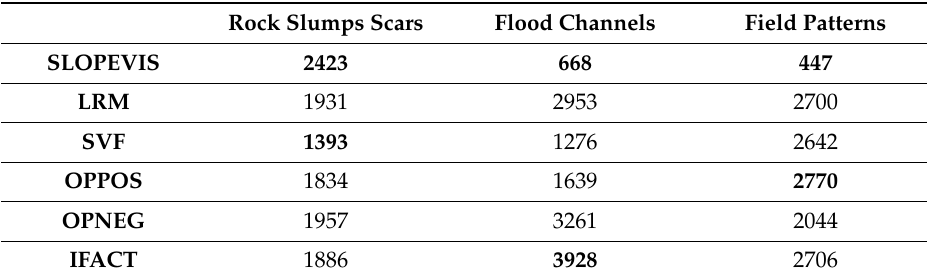
Figure 5. Example of digitalization (detected field patterns within a selected window) using selected VTs. Strong differences are noticeable in the total length detected but also in segment directions and positions, affecting the visual interpretation. Table 3. Total cumulated length (in m) detected of selected landforms under different VTs. Best and worst values for each landform type are given in bold.